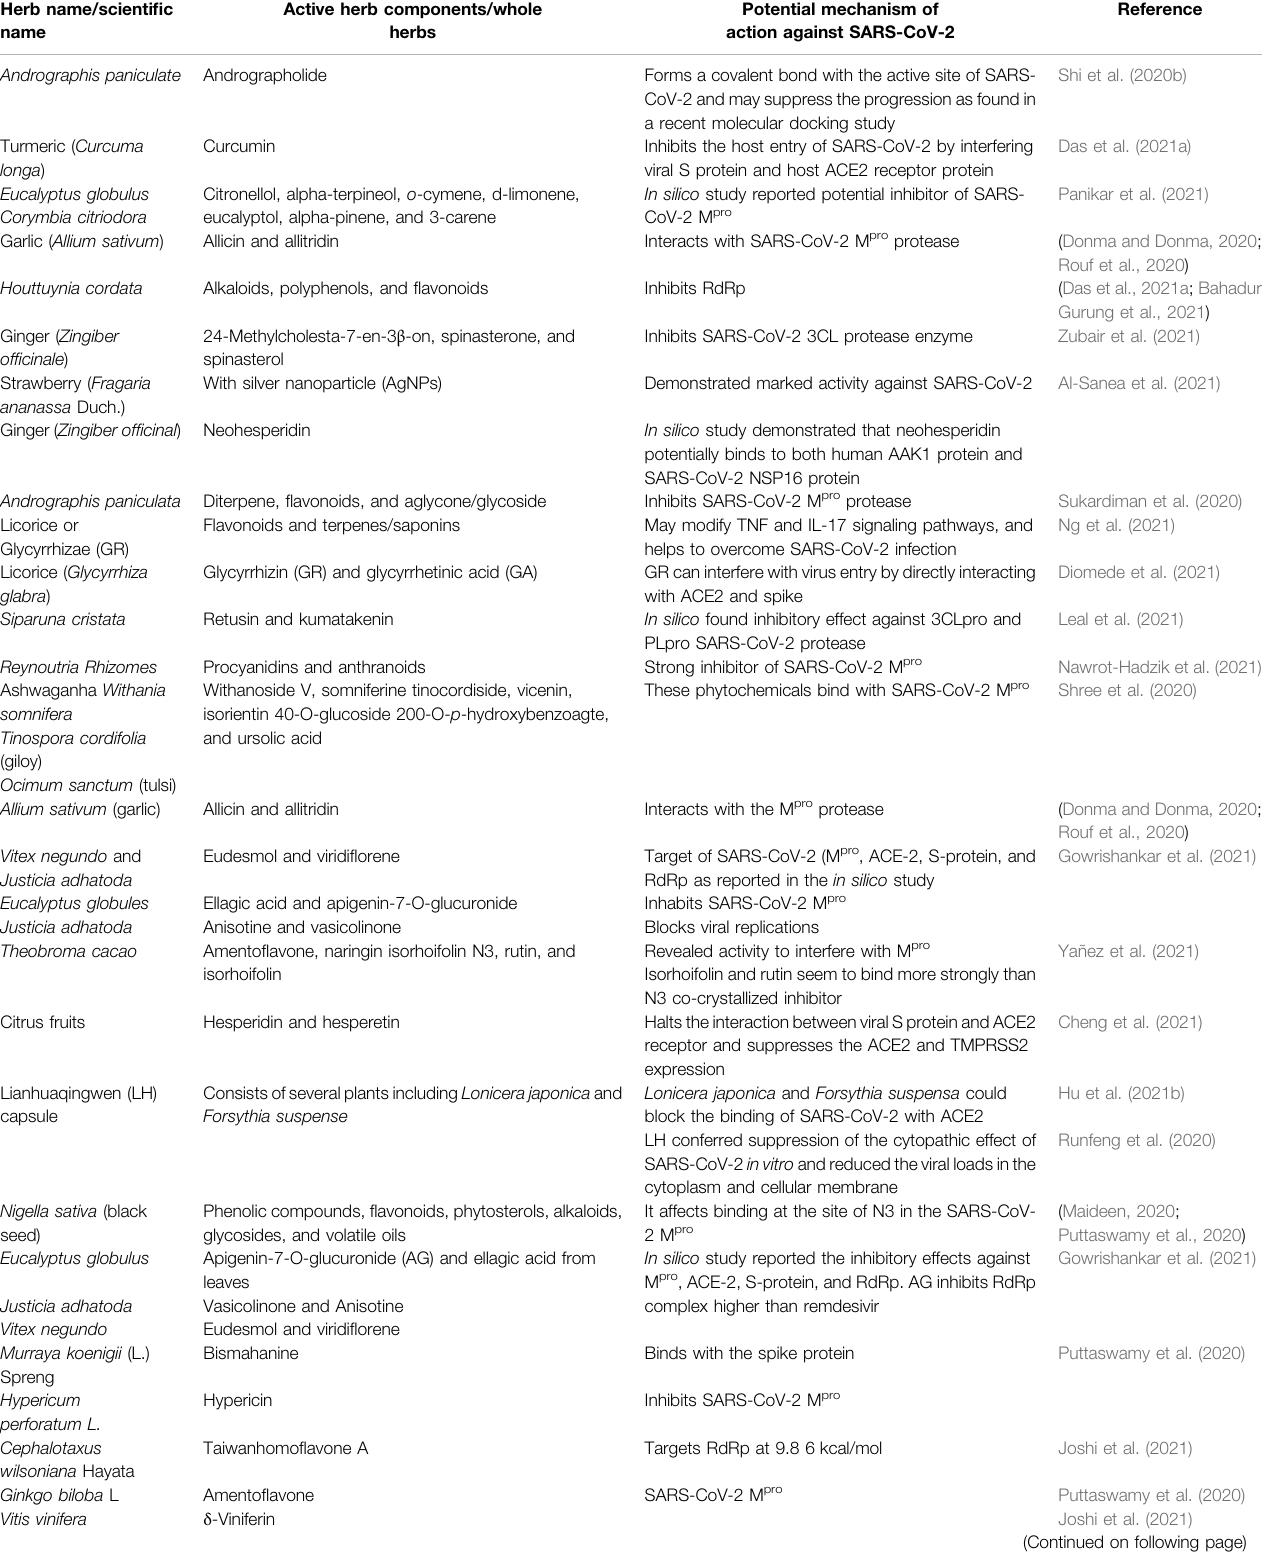
TABLE 10 | Herbs using against COVID-19